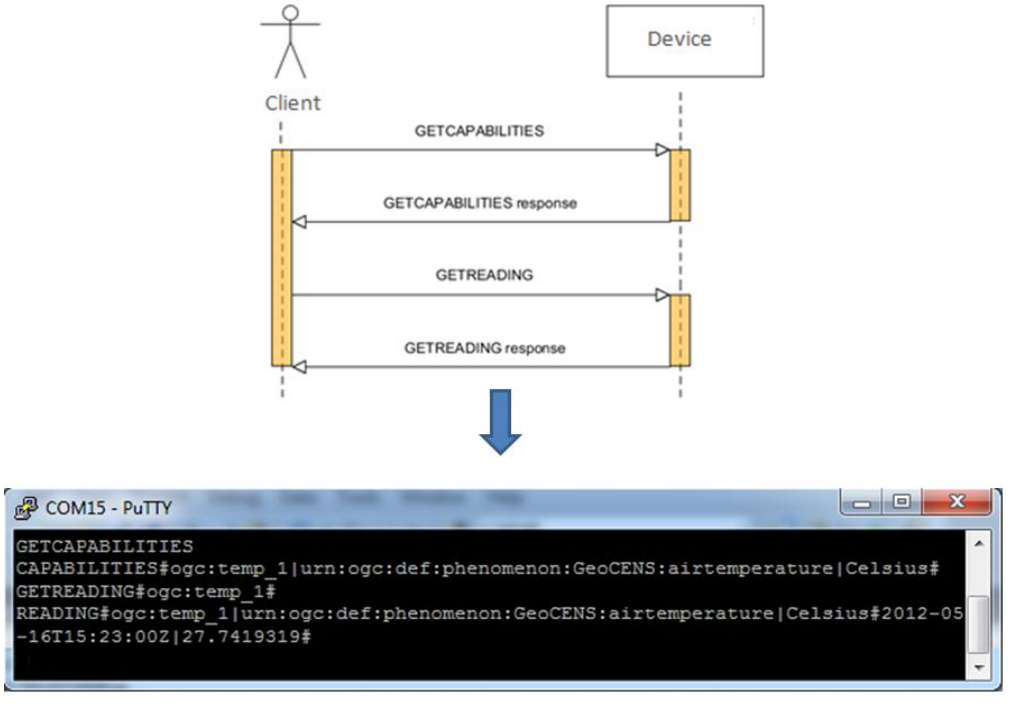
Figure 3. Procedures of the sensor